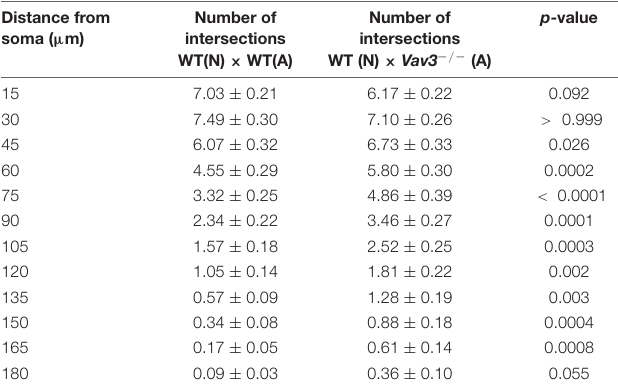
TABLE 6 | Intersection numbers of wildtype neurons cultured with Vav3 − / − astrocytes in comparison to the control condition after cultivation time of 17 days.